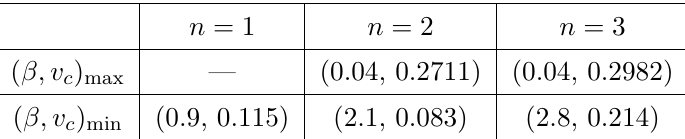
Table 1 . The local maxima and minima of v c for n = 1 ; 2 ; 3, and (cid:12) 2 [0 ;